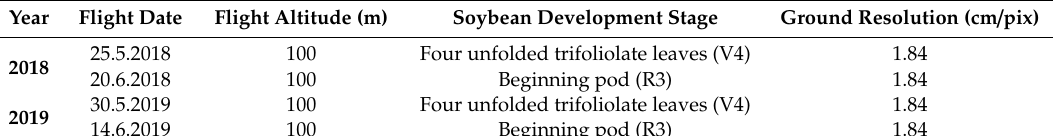
Figure 1. Plot images of soybean in the V4 phase: ( a ) four unfolded trifoliolate leaves and the ( b ) R3 phase—beginning pod; images were taken with the UAV (Unmanned Aerial Vehicle) in 2018. In both trial years, photos were taken on a sunny day, at a wind speed equal to or less than 10 m/s, and between 10:00 and 14:00; more details about the UAV photo acquisition are given in Table 2. Table 2. Basic details about acquisition of photos.